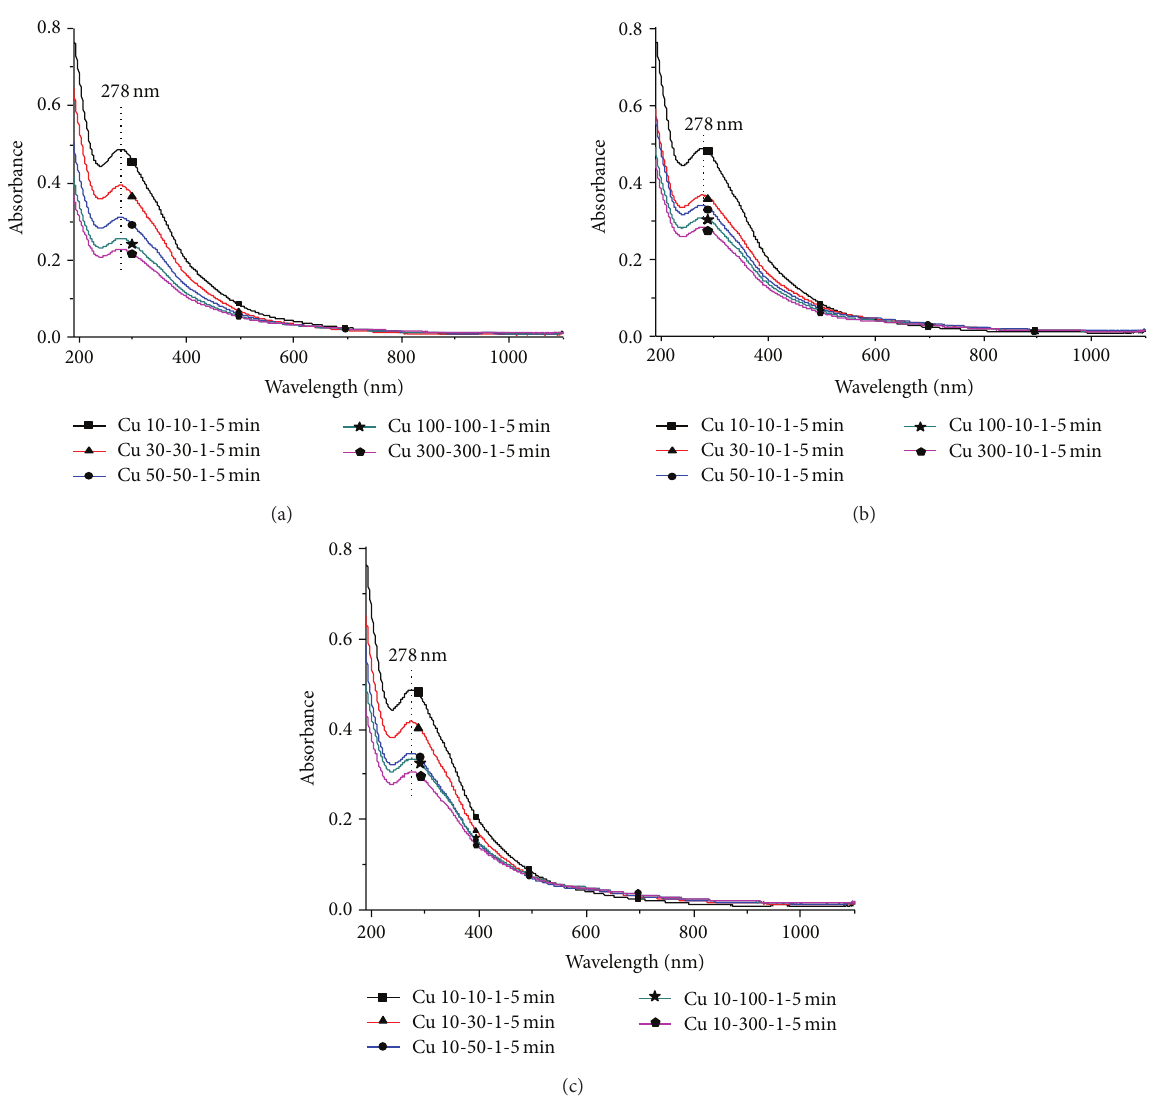
Figure 6: Copper fluid UV-Vis analysis results; (a) 𝑇